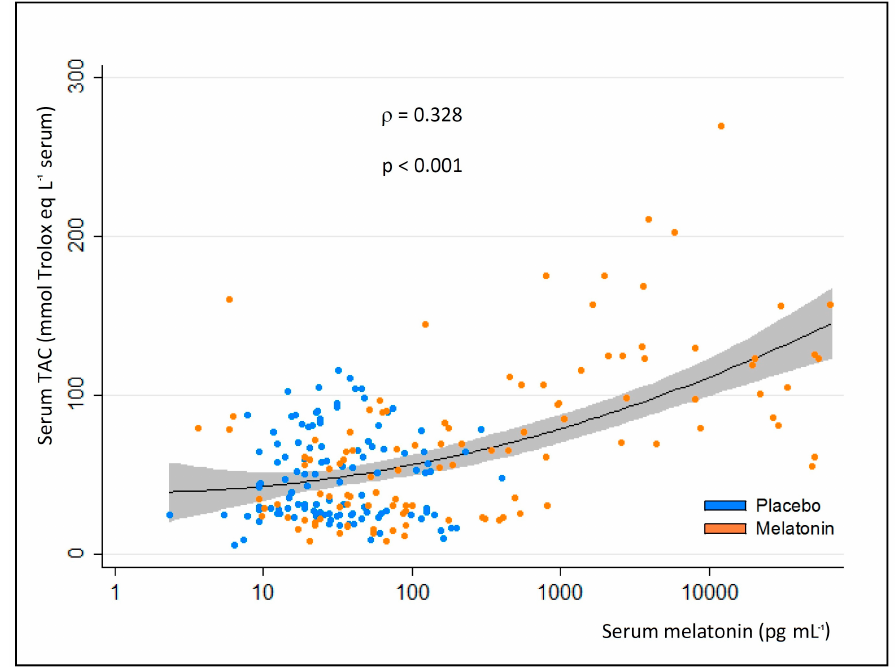
Figure 4. Correlation between serum melatonin and serum total antioxidant capacity (TAC) measured in all available samples, taken from critically-ill patients at midnight and at 14:00 h of the 3rd, 4th, and 8th ICU day; the patients had received melatonin or placebo. Analysis was done by Spearman rank correlation. ρ : Spearman correlation coefficient. Line represents the linear prediction; gray belt is the 95% confidence interval; points are all the available couples of observed values.